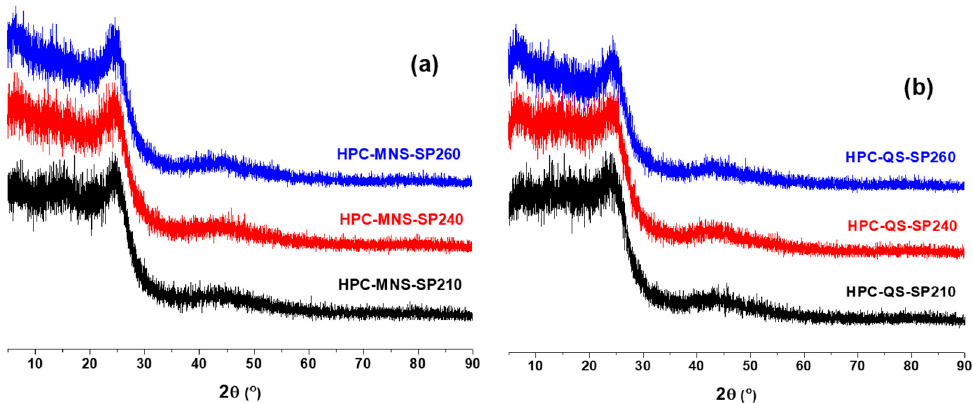
Figure 7. XRD patterns of HPC-MNS ( a ) and HPC-QS ( b ) derived pitches.